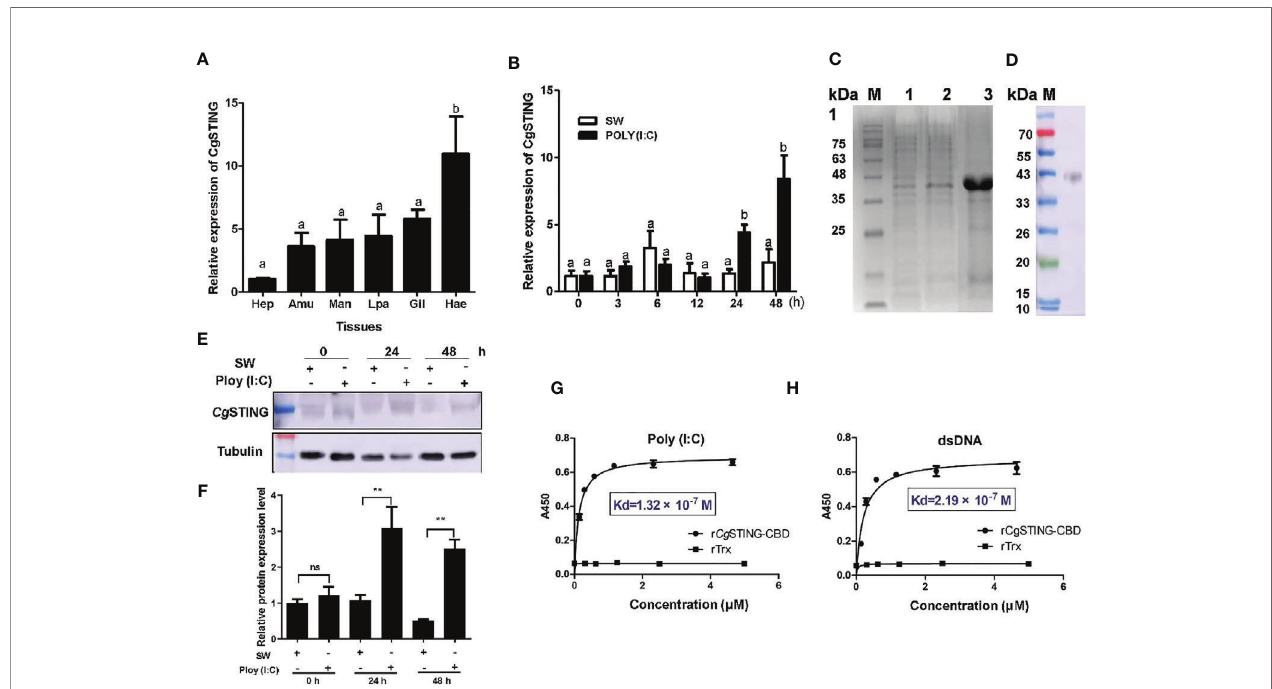
FIGURE 4 | The binding activity of Cg STING to viral nucleic acid. (A) The tissues distribution of the Cg STING mRNA. Man, mantle; Hep, hepatopancrease; Amu, adductor muscle; He, hemolymph; Lpa, labial palp; Gil, gill. (B) The temporal expression pro fi le of Cg STING mRNA after Poly (I:C) stimulation. (C) The recombination protein of Cg STING-CBD. Lane M: standard protein molecular weight marker; Lane 1: negative control (without induction); Lane 2: induced r Cg STING; Lane 3: puri fi ed r Cg STING. (D) Lane 1: Speci fi city detection for polyclonal antibody of Cg STING-CBD by Western blot. (E) The protein level of Cg STING after Poly (I:C) stimulation. (F) The statistical analysis of Cg STING protein level using ImageJ. (G) The binding activity of r Cg STING-CBD to Poly (I:C) and (H) dsDNA. A450 was the absorbance value at 450 nm, and the Kd values were calculated by GraphPad Prism 5. The different letters show the existence signi fi cant differences comparing with other groups ( p < 0.05). ** p < 0.01; ns, not signi fi